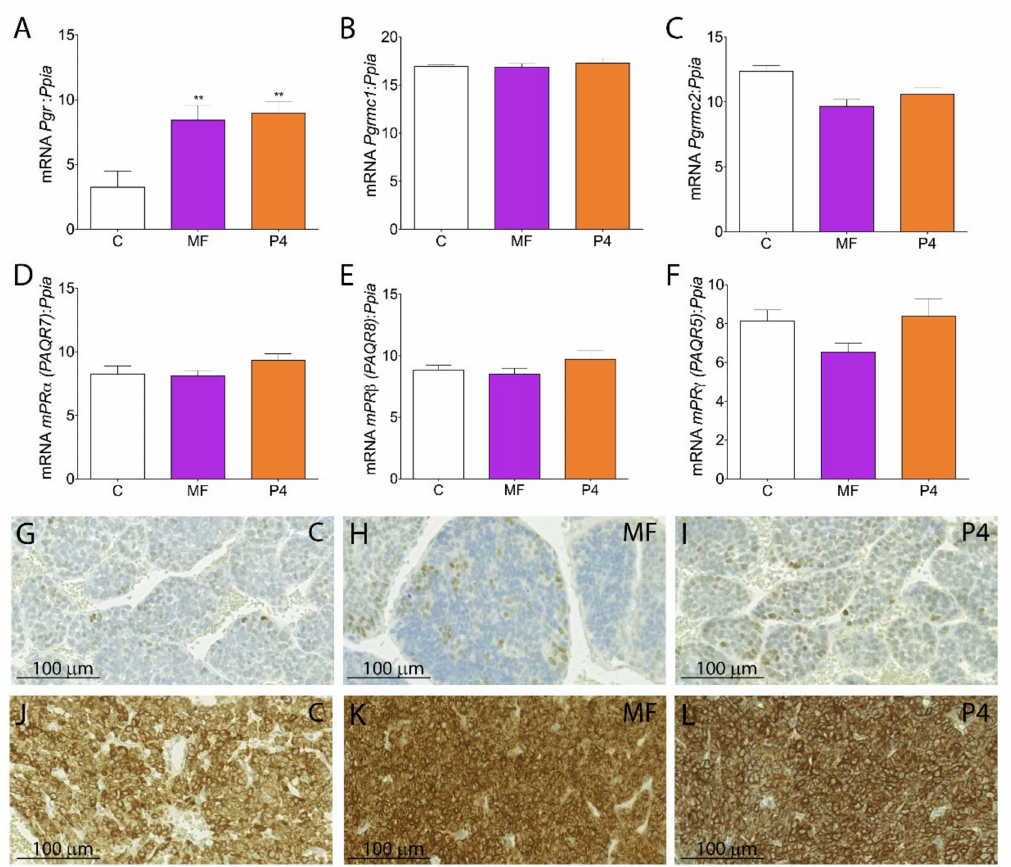
Figure 3. Pgr gene profiling in MF- and P4-treated transgenic Inh α / Tag TG mice and BLTK-1 cells proliferation and invasion. qPCR analysis of Pgr ( A ), Pgrmc1 ( B ), Pgrmc2 ( C ), Paqr7 (mPR α ) ( D ), Paqr8 (mPR β ) ( E ), and Paqr5 (mPR γ ) ( F ) expression in the non-, MF- and P4-treated tumors of Inh α / Tag TG mice. Each bar represents the mean ± SEM relative to Ppia. Immunohistochemical staining of PGR in the control ( G ), MF-treated ( H ) and P4-treated ( I ) tumors and of PGRMC1 in control ( J ), MF-treated ( K ) and P4-treated ( L ) LCTs of Inh α / Tag TG mice. Scale bar, 100 µ m. Asterisks indicate significant di ff erences between the control and treated groups (**, p < 0.01). C, control; Inh α / Tag TG mice; transgenic mice expressing the SV40 Taq oncogene under the inhibin α promoter; LCT, Leydig cell tumor; MF, mifepristone; P4,